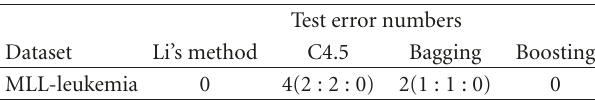
Table 6: The test error numbers by four classification models